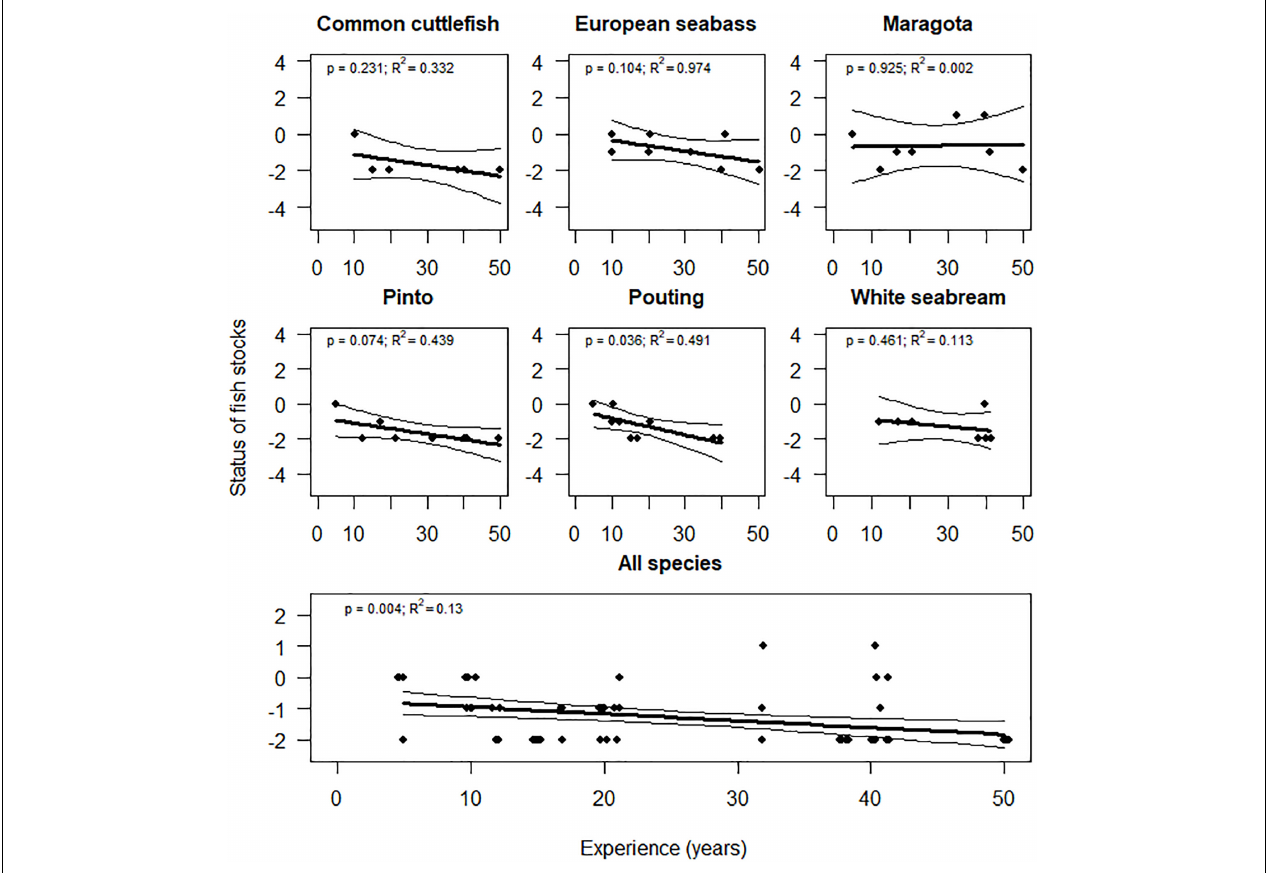
FIGURE 1 | Effect of the experience of recreational fishers on the perceived conservation status of fish stocks (from –2 meaning very negative to 2 meaning very positive). Predictions (thick lines), 95% confidence interval (thin lines) and observations (dots) estimated by GLM are showed. P -values and goodness of fit of the model ( R 2 ) are also showed. Only frequently targeted species, identified by more than 20% of the fishers, were included in the results by species.